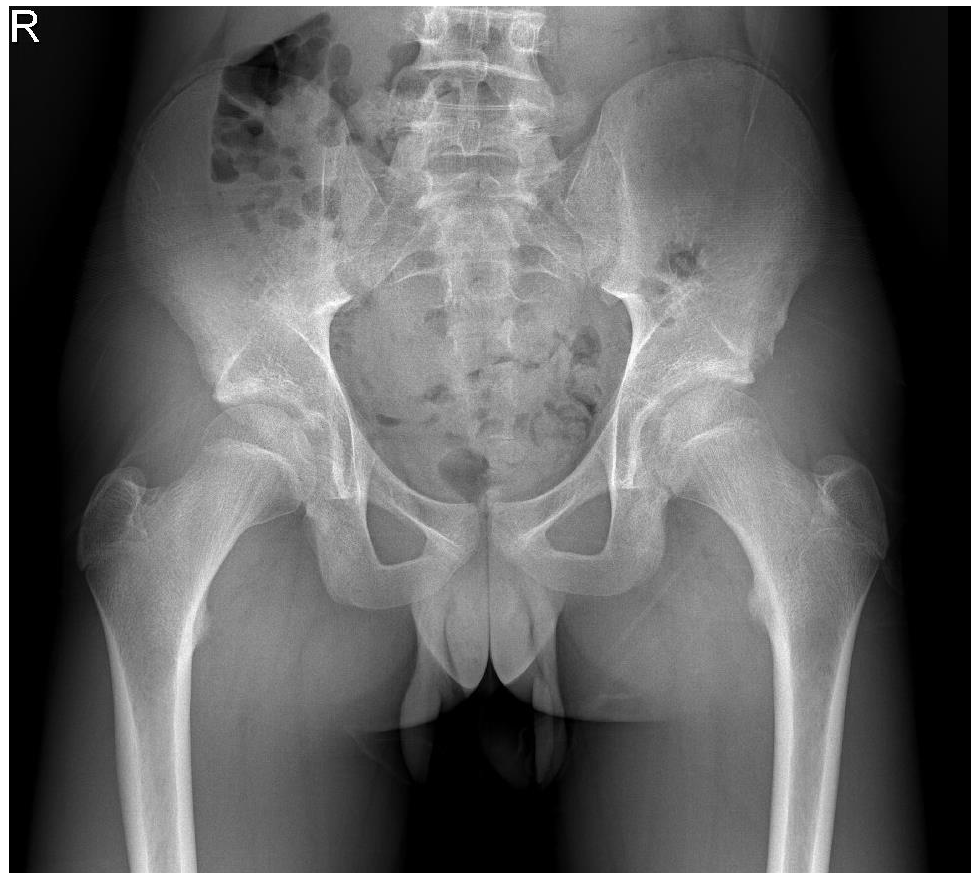
Figure 3. Plain pelvic radiograph 6 weeks after surgical removal of the heterotopic ossification.